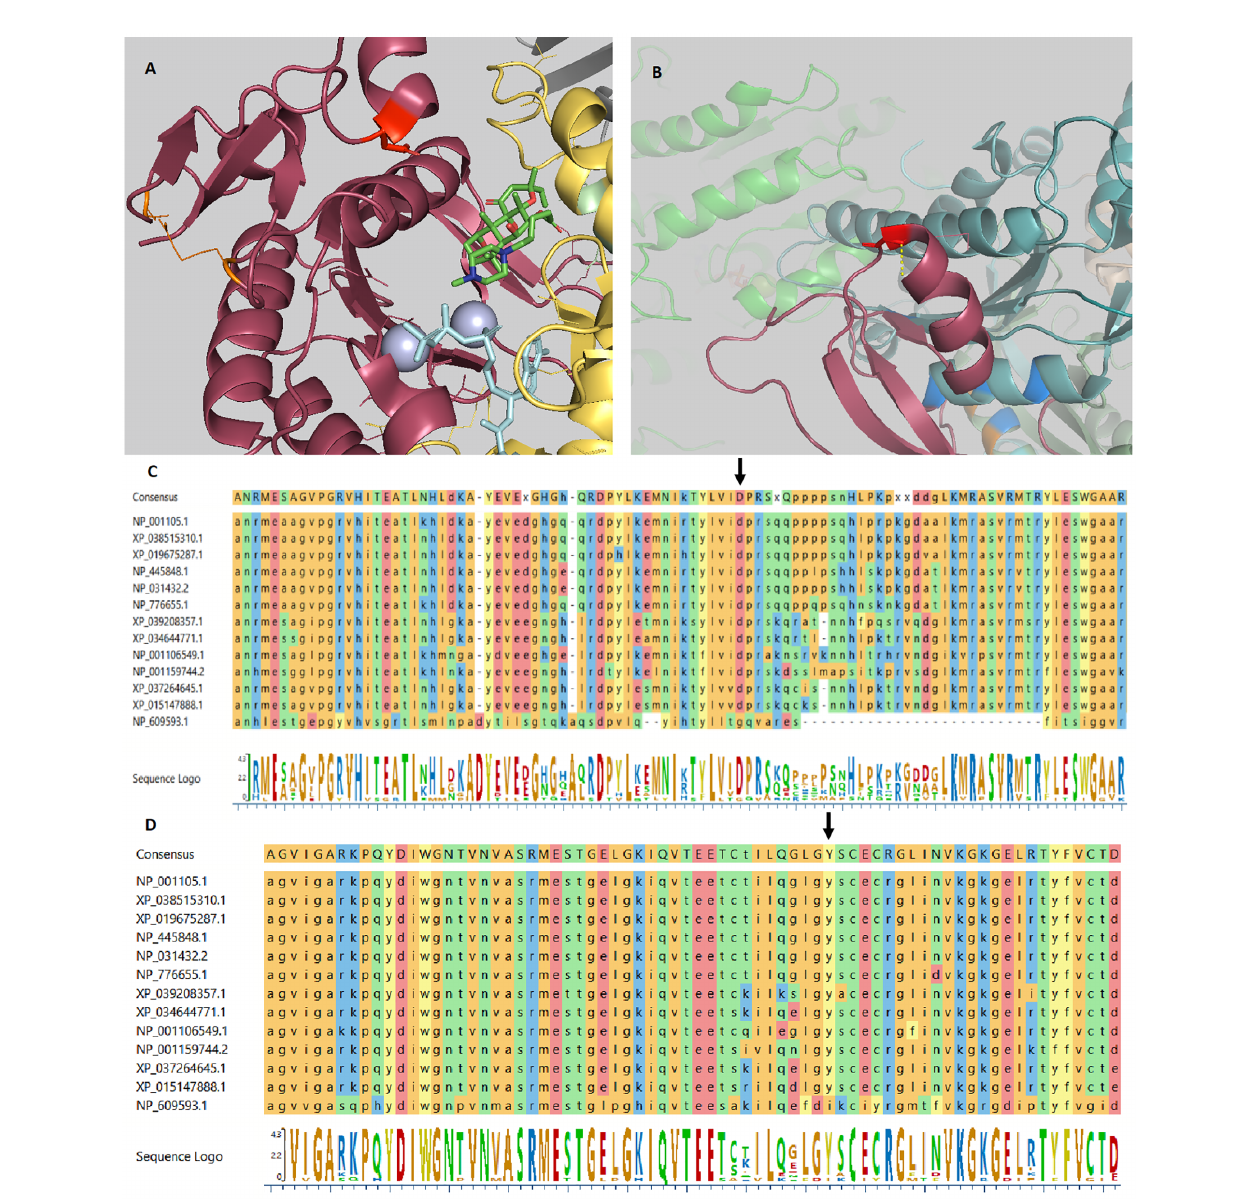
FIGURE 1 | ADCY7 variants crystal structure. (A) The crystal structure of G a s.VC1.IIC2 domain in complex with the substrate analog TNP-ATP based on pdb 2GVZ; ADCY5. The Asp439 residue is depicted as a red tooth stick. The adenylate cyclase inhibitor foskolin shown as green tooth sticks and the TNP-ATP substrate analog as aquamarine tooth sticks. The two manganese ions in grey. Two residues are depicted in orange are mutated in GUCY2D causing Leber congenital amaurosis 1. VC1 in salmon, IIC2 in yellow, G a s in grey. Residues involved in VC1.IIC2 interaction shown as tooth sticks. (B) The crystal structure of the IIC2 domain based on pdb 6R4P; ADCY9. Gly1045 shown in red with a polar interaction indicated by a yellow dashed line to the backbone of residue Gly1043. Gly1043 allow a sharp turn to the loop connecting a -helix 15 and b -strand 19. Replacing Gly1045 with arginine can be predicted to prevent this turn. Residues depicted in blue are mutated in GUCY2D causing Leber congenital amaurosis 1. In the background the VC1 domain (green) can be seen. (C) Alignment of ADCY7 sequences displaying conservation from homo sapiens at the top to Drosophila melanogaster at the bottom. Asp439 indicated by an arrow. (D) Alignment of ADCY7 sequences displaying conservation from homo sapiens at the top to Drosophila melanogaster at the bottom displaying conservation of Gly1045 indicated by an